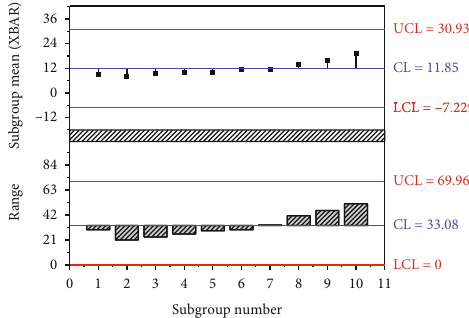
Figure 5: Independent samples t -test for English reading posttest scores of control and experimental